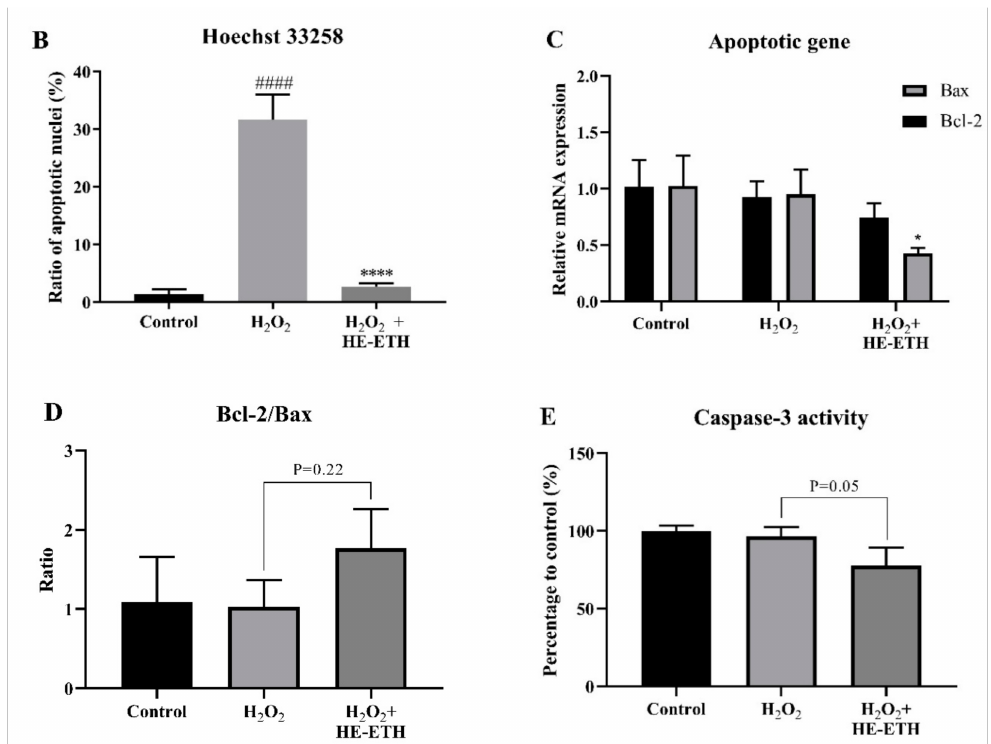
Figure 7. Anti-apoptotic activities of ethanolic extract (HE-ETH) on H 2 O 2 -treated HT22 neurons. HT22 was co-incubated with 250 µ M H 2 O 2 and 400 µ g / mL HE-ETH before subjected to apoptosis assays. ( A ) Representative images of apoptotic nuclei stained by Hoechst 33258 with ( B ) ratio of apoptotic nuclei, ( C ) quantification of Bcl-2 and Bax mRNA expression, ( D ) ratio of Bcl-2 / Bax and ( E ) caspase 3 activity. All values presented correspond to mean ± SD of triplicates ( n = 3). Values of #### p < 0.0001 compared with control, and * p < 0.05; **** p < 0.0001 compared with H 2 O 2 -treated group were considered as statistically significant. Scale bar denotes 100 µ